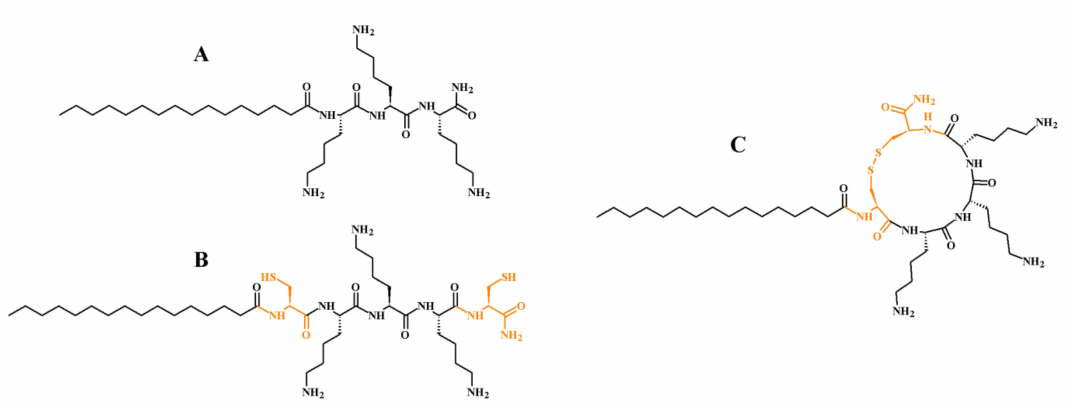
Figure 1. Linear lipopeptides C 16 -KKK-NH 2 ( A ) parent molecule and its analog before ( B ) and after cyclization ( C ). Cysteine / cystine residues are colored orange.